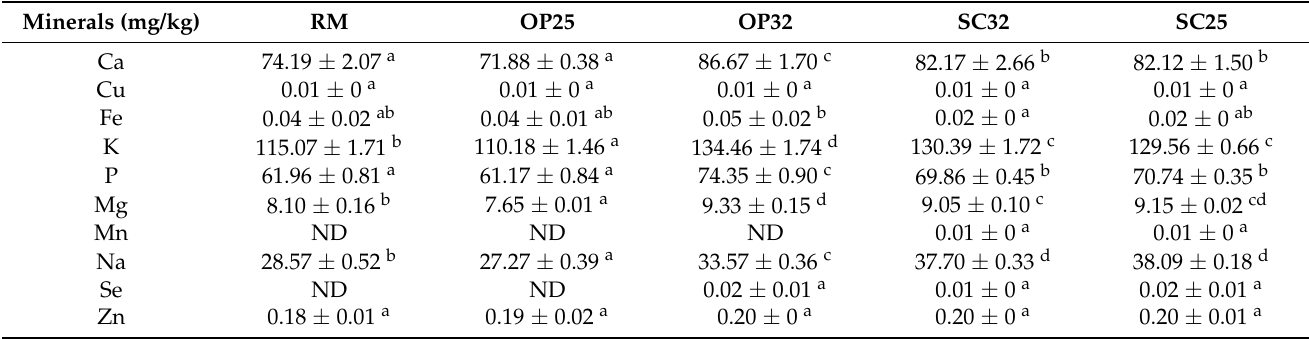
Table 4. Mineral compositions of raw milk and